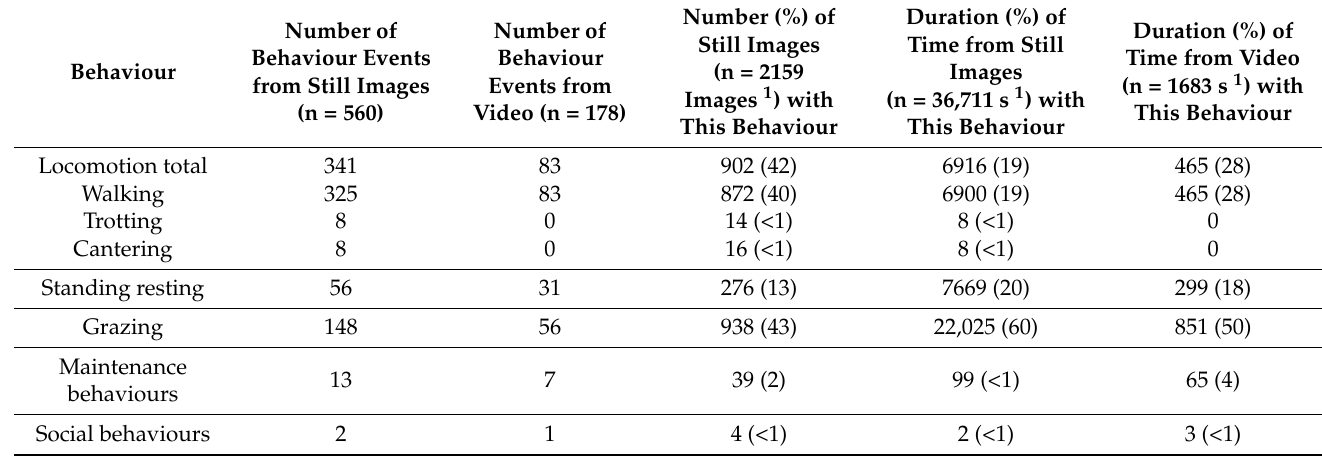
Table 9. The number and durations of identifiable behaviours calculated from camera trap still images and videos.